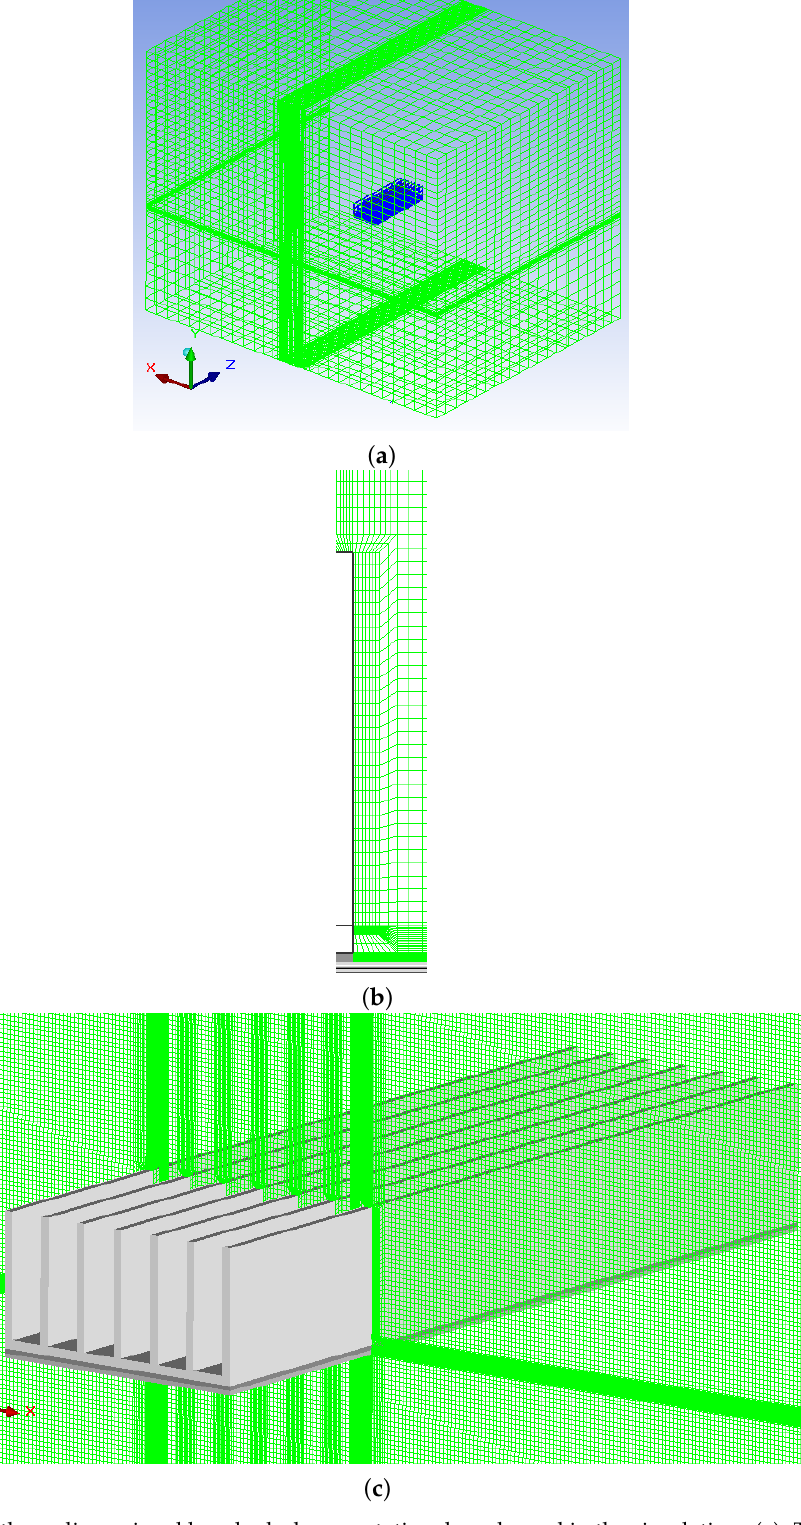
Figure 2. A three-dimensional hexahedral computational mesh used in the simulations ( a ). The blue region is the fin array. Zoomed views of a typical mesh resolution on the fin walls ( b ) and a cross-section of the mesh around the fins ( c